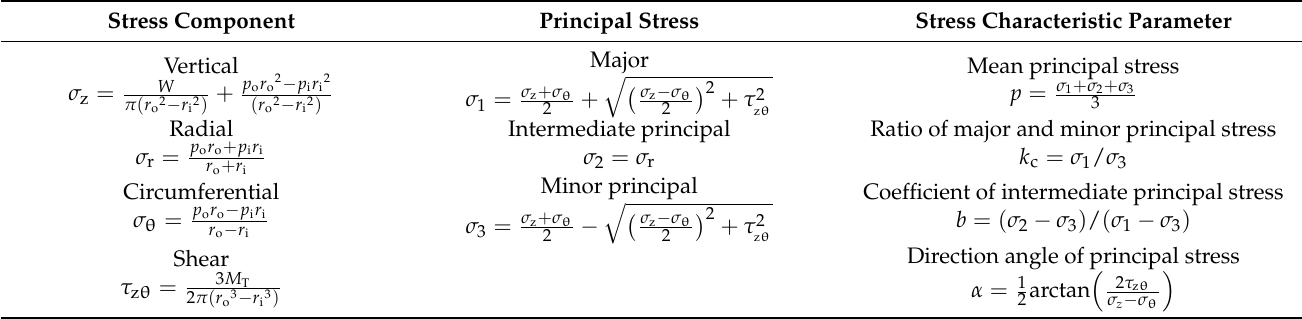
Table 2. Equations for data